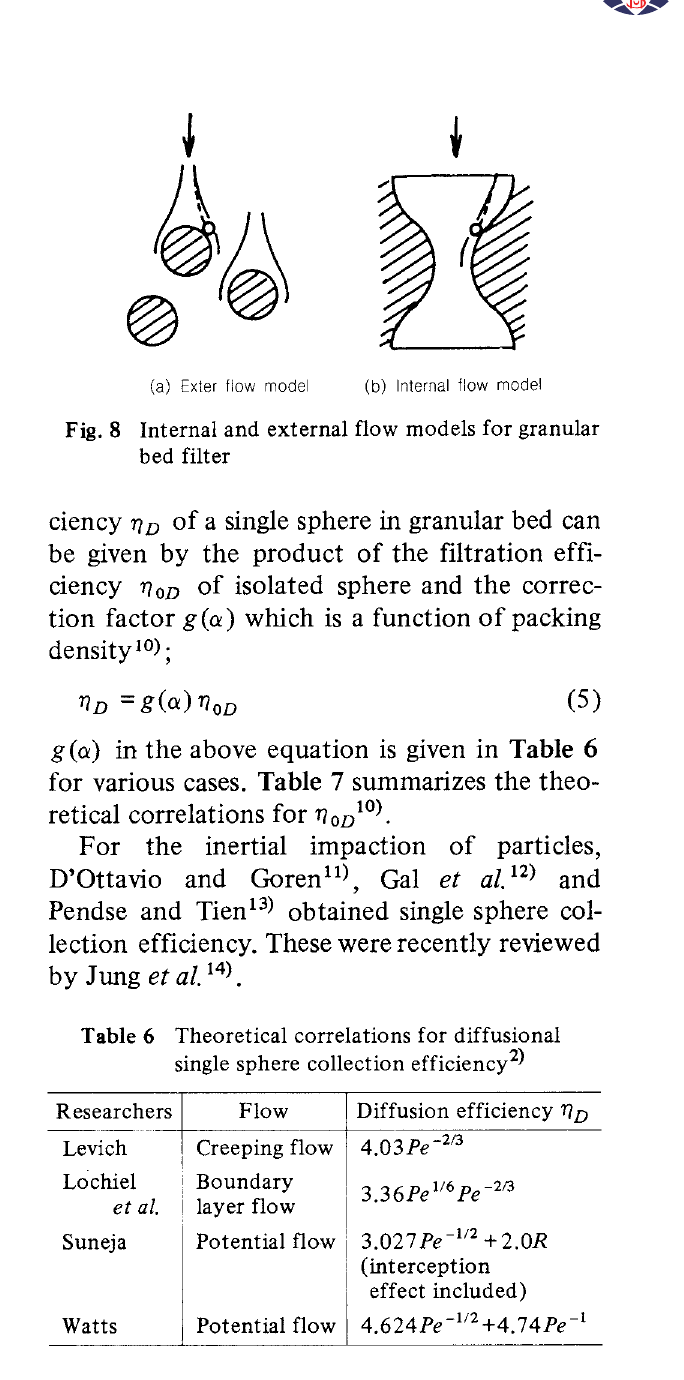
Fig. 8 Internal and external flow models for granular bed filter